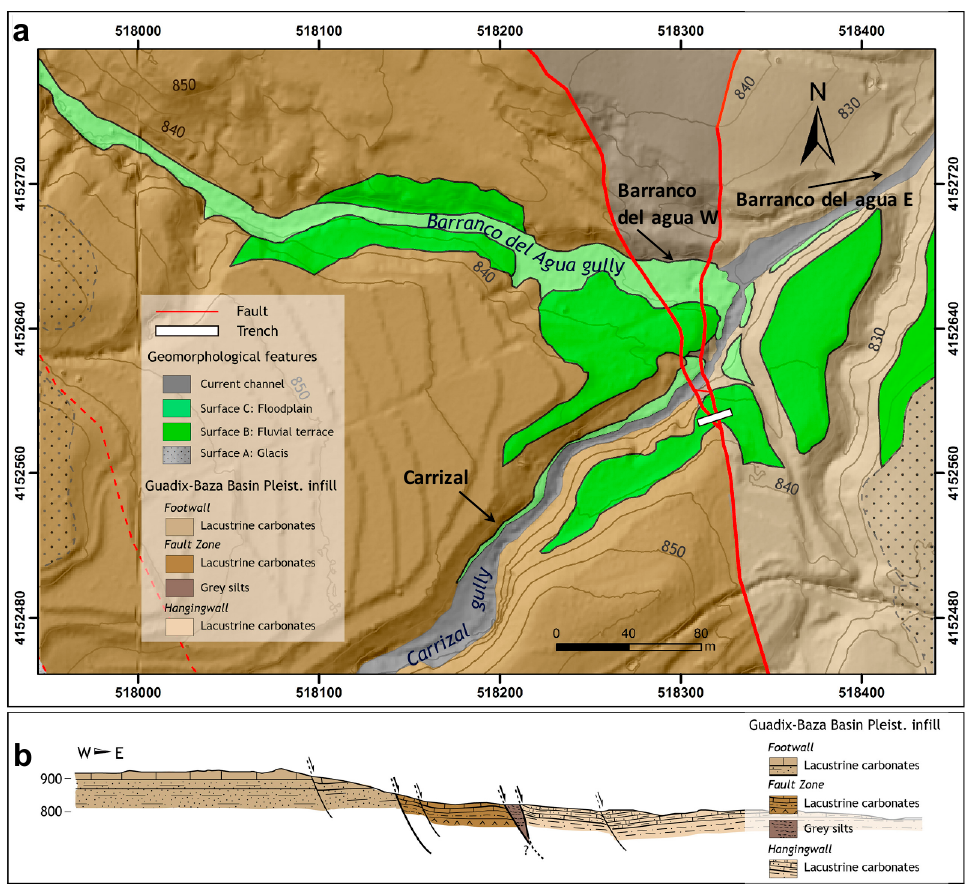
Figure 5. ( a ) Geological–geomorphological map of the central sector. Location in Figure 1. ( b ) Geological cross section along the central sector of the Baza Fault. Modified from Castro and collaborators [63].